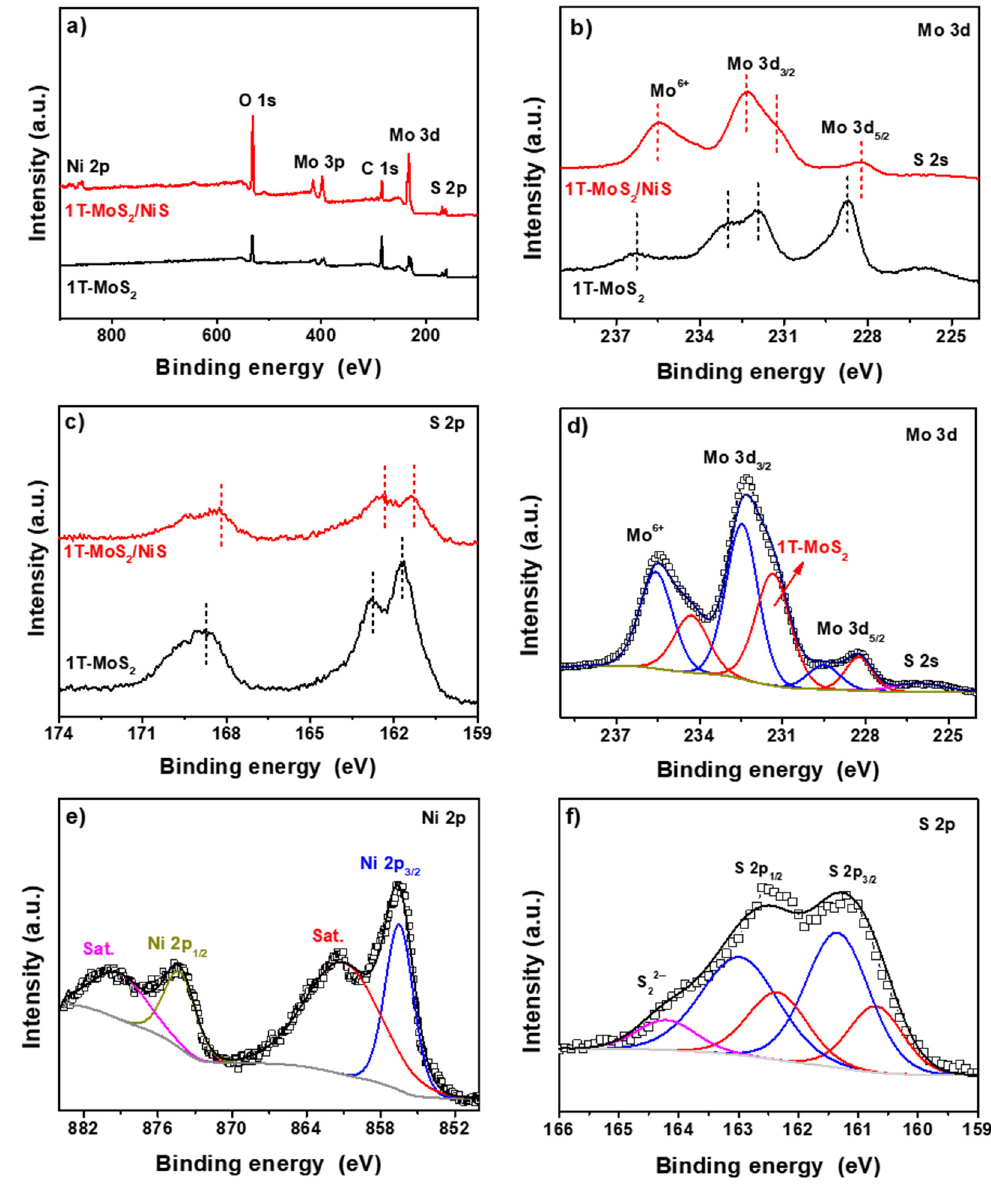
Figure 3. ( a ) XPS survey spectra of 1T-MoS 2 and 1T-MoS 2 /NiS; high-resolution peaks of ( b ) Mo 3d and ( c ) S 2p of 1T-MoS 2 and 1T-MoS 2 /NiS; high-resolution peaks and fitting results of 1T-MoS 2 /NiS: ( d ) Mo 3d, ( e ) Ni 2p and ( f ) S 2p.